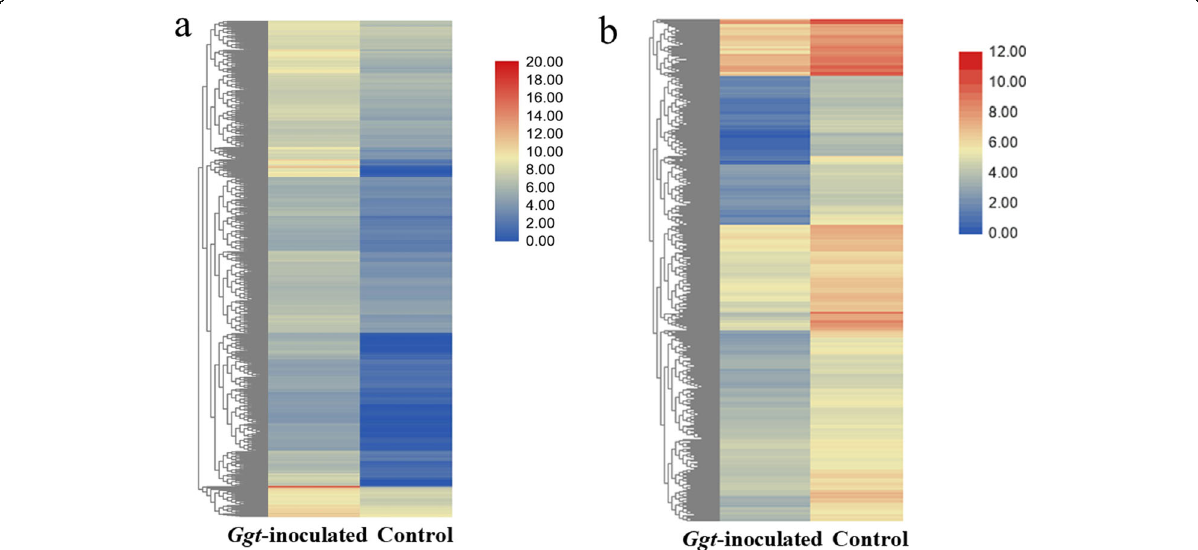
Fig. 4 Hierarchical clustering analysis of DEGs. a Hierarchical clustering analysis of up-regulated DEGs. b Hierarchical clustering analysis of down- regulated DEGs. The DEGs were clustered based on the log 10 (FPKM+ 1). Dark red indicates high expressed genes, dark blue indicates low expressed genes. Color from red to blue denotes the numeric values from large to